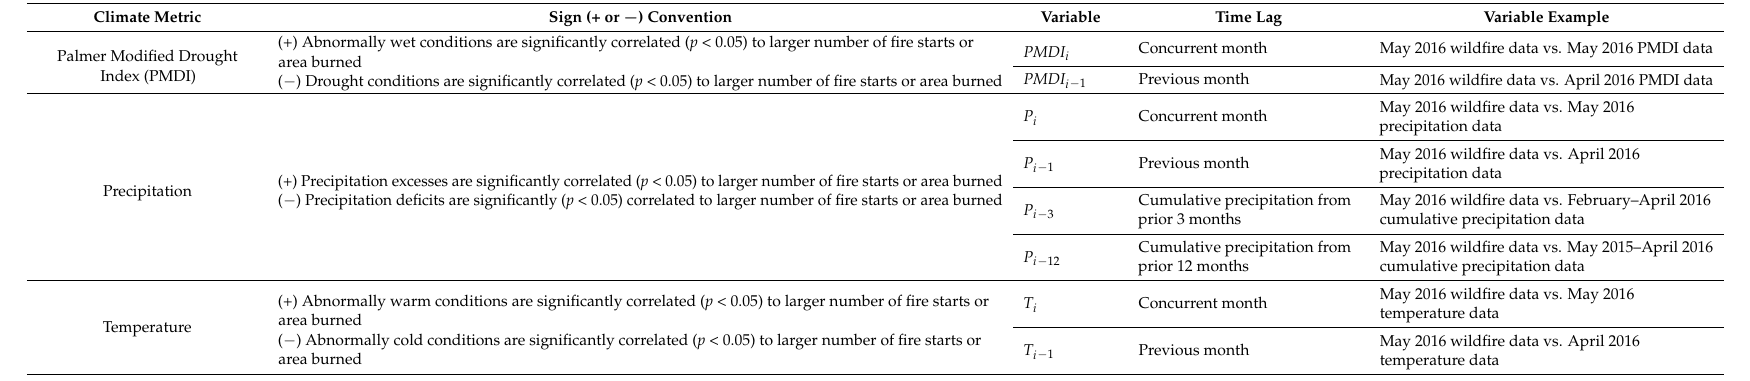
Table 1. Climate variable nomenclature descriptions, sign conventions, and usage examples. This table is to be used in conjunction with Tables 2 and 3. Climate